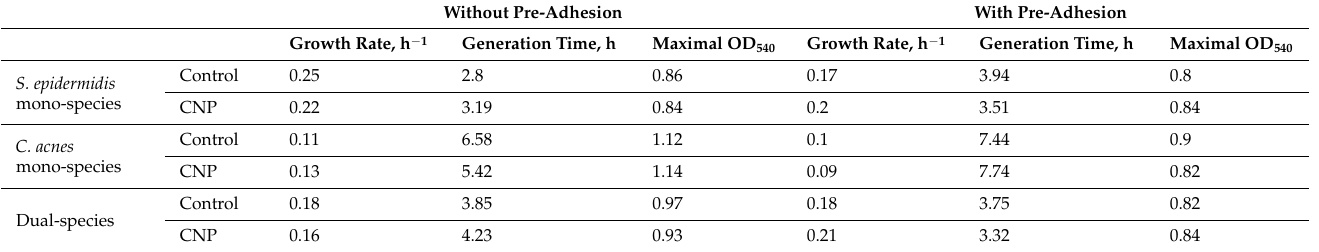
Table 3. Kinetic parameters of mono-species and dual-species cultures in different model systems.